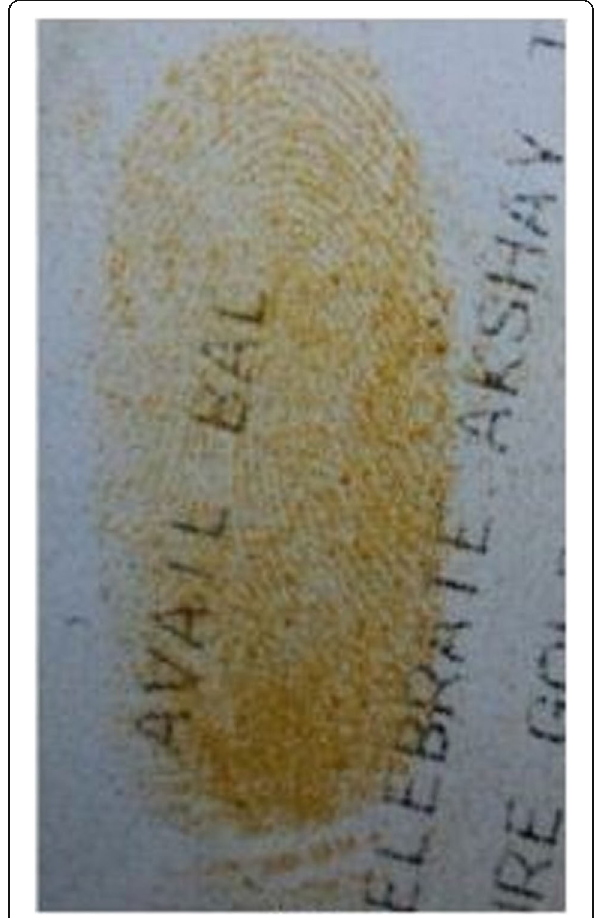
Fig. 3 Example of fingerprints on thermal paper developed with turmeric powder (adapted from Garg et al.